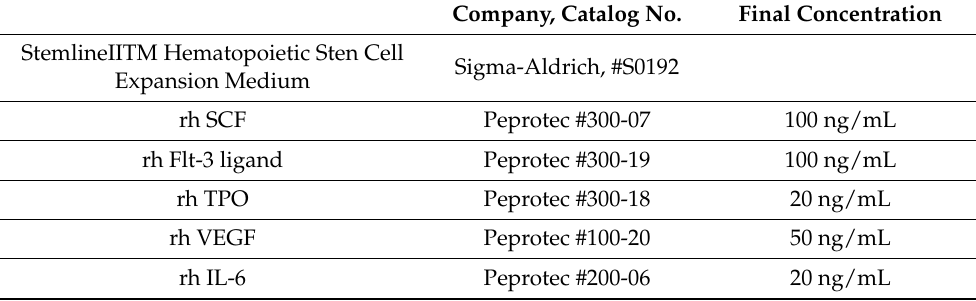
Table 1. Contents of the QQ Culture Medium. Company, Catalog No. Final